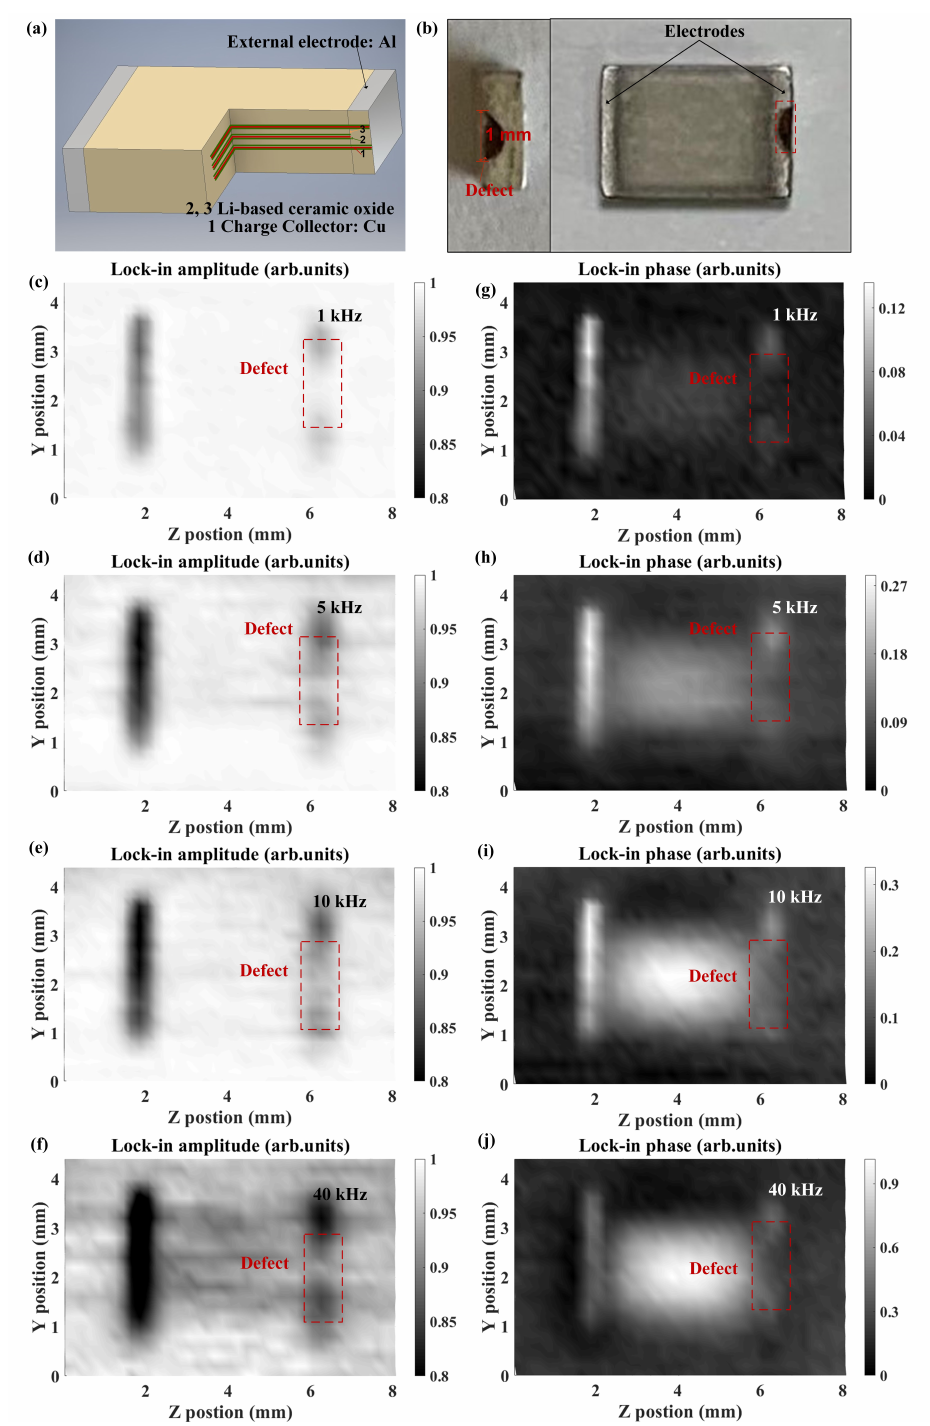
Figure 3. ( a ) Battery schematic. The ceramic solid battery consists of external aluminum electrodes, Li-based ceramic oxide inner electrodes (noted as 2), a Li-based ceramic oxide electrolyte (noted as 3), and a copper charge collector (indicated as 1). ( b ) A photograph of the battery with dimension 4 × 3 × 1mm 3 . Distinctly visible is the defect on the external electrode. ( c – f ) Maps of the R of LIA for modulation frequencies of 1kHz, 5kHz, 10kHz and 40kHz. ( g – j ) Maps of the θ of LIA for modulation frequencies of 1kHz, 5kHz, 10kHz and 40kHz,